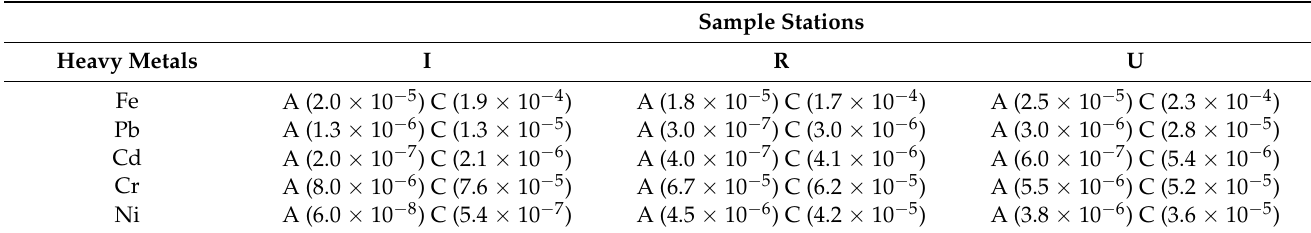
Table 5. CDI ing for Vernonia amygdalina in both adults and